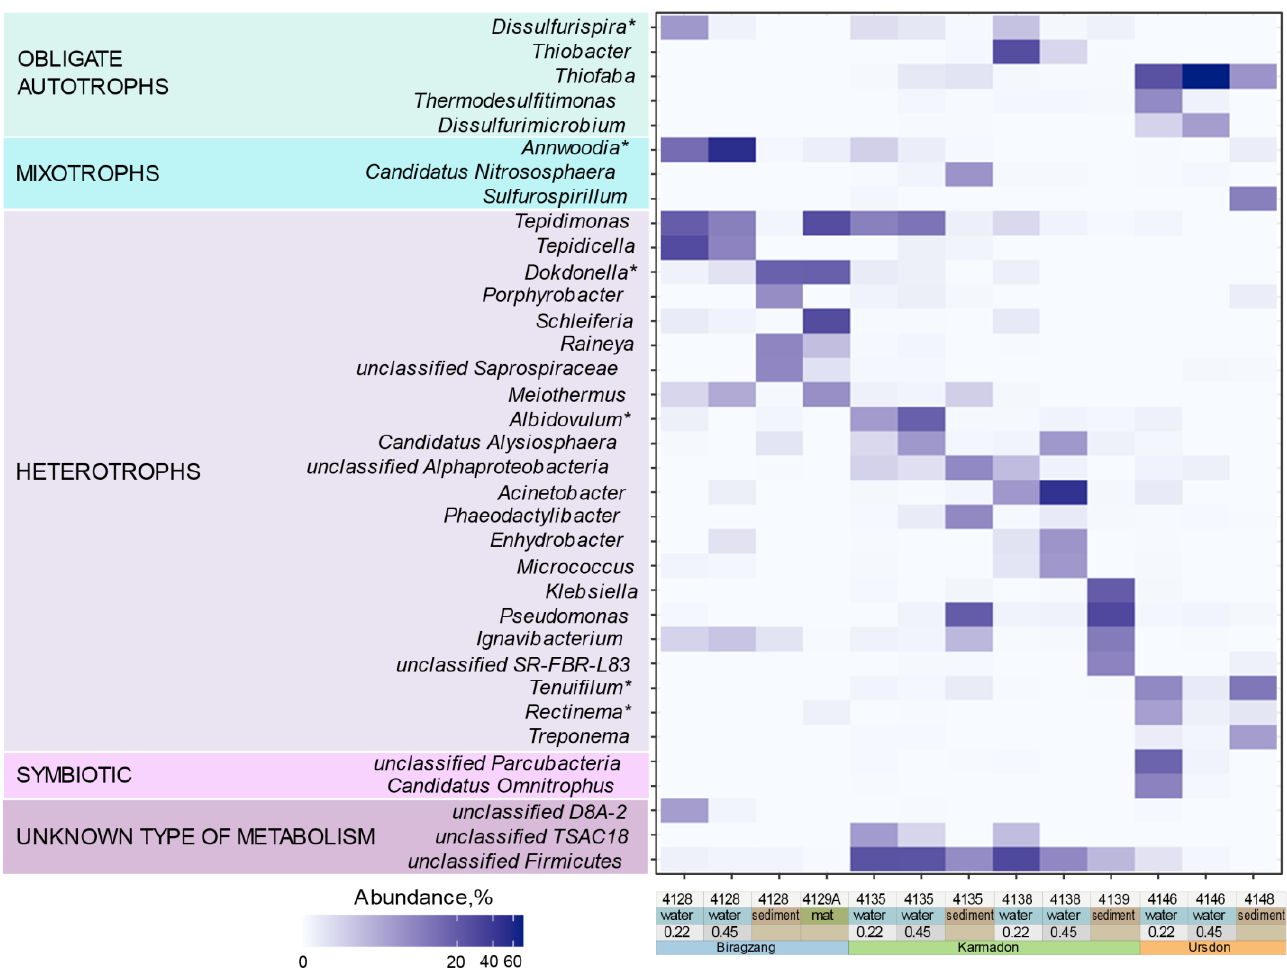
Figure 3. Abundance heatmap of prokaryotic genera, comprising more than 5% at least in one of the samples. Microbial taxa are grouped by metabolic properties of closest cultivated relatives. Asterisks near the taxa names indicate that taxonomy, assigned by DADA-2 Bayesian classifier was further refined by BLAST search against NCBI type material 16S rRNA database.